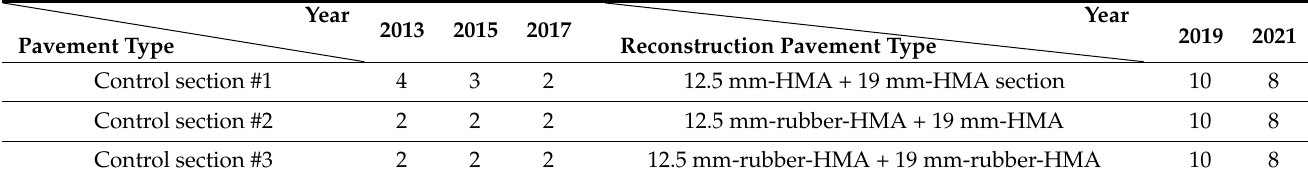
Figure 13. Noise test results for the old pavement section and pavement sections after construction. Table 8. PASER rating data of the old pavement and new reconstruction pavement.